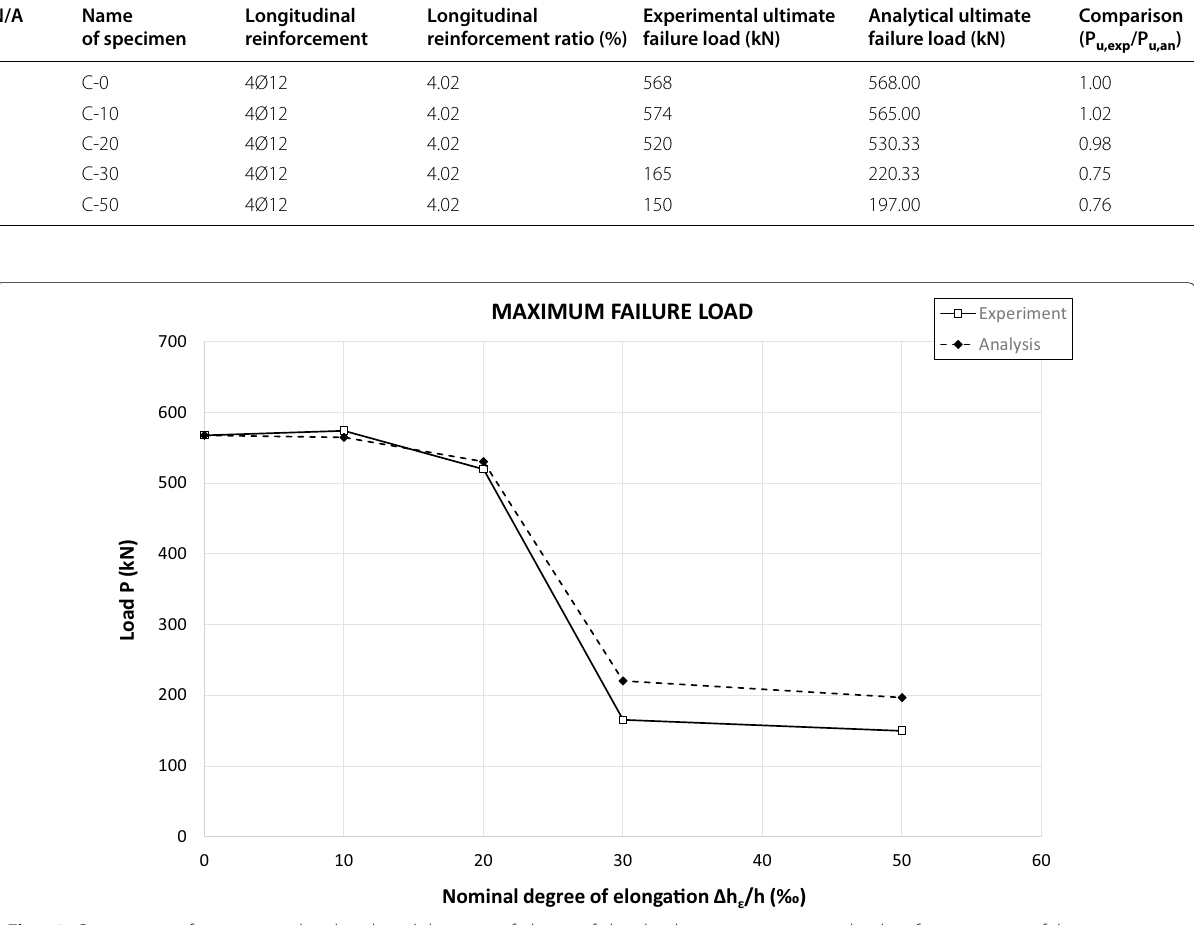
Fig. 13 Comparison of experimental and analytical diagrams of ultimate failure load against compressive loading for specimens of the current